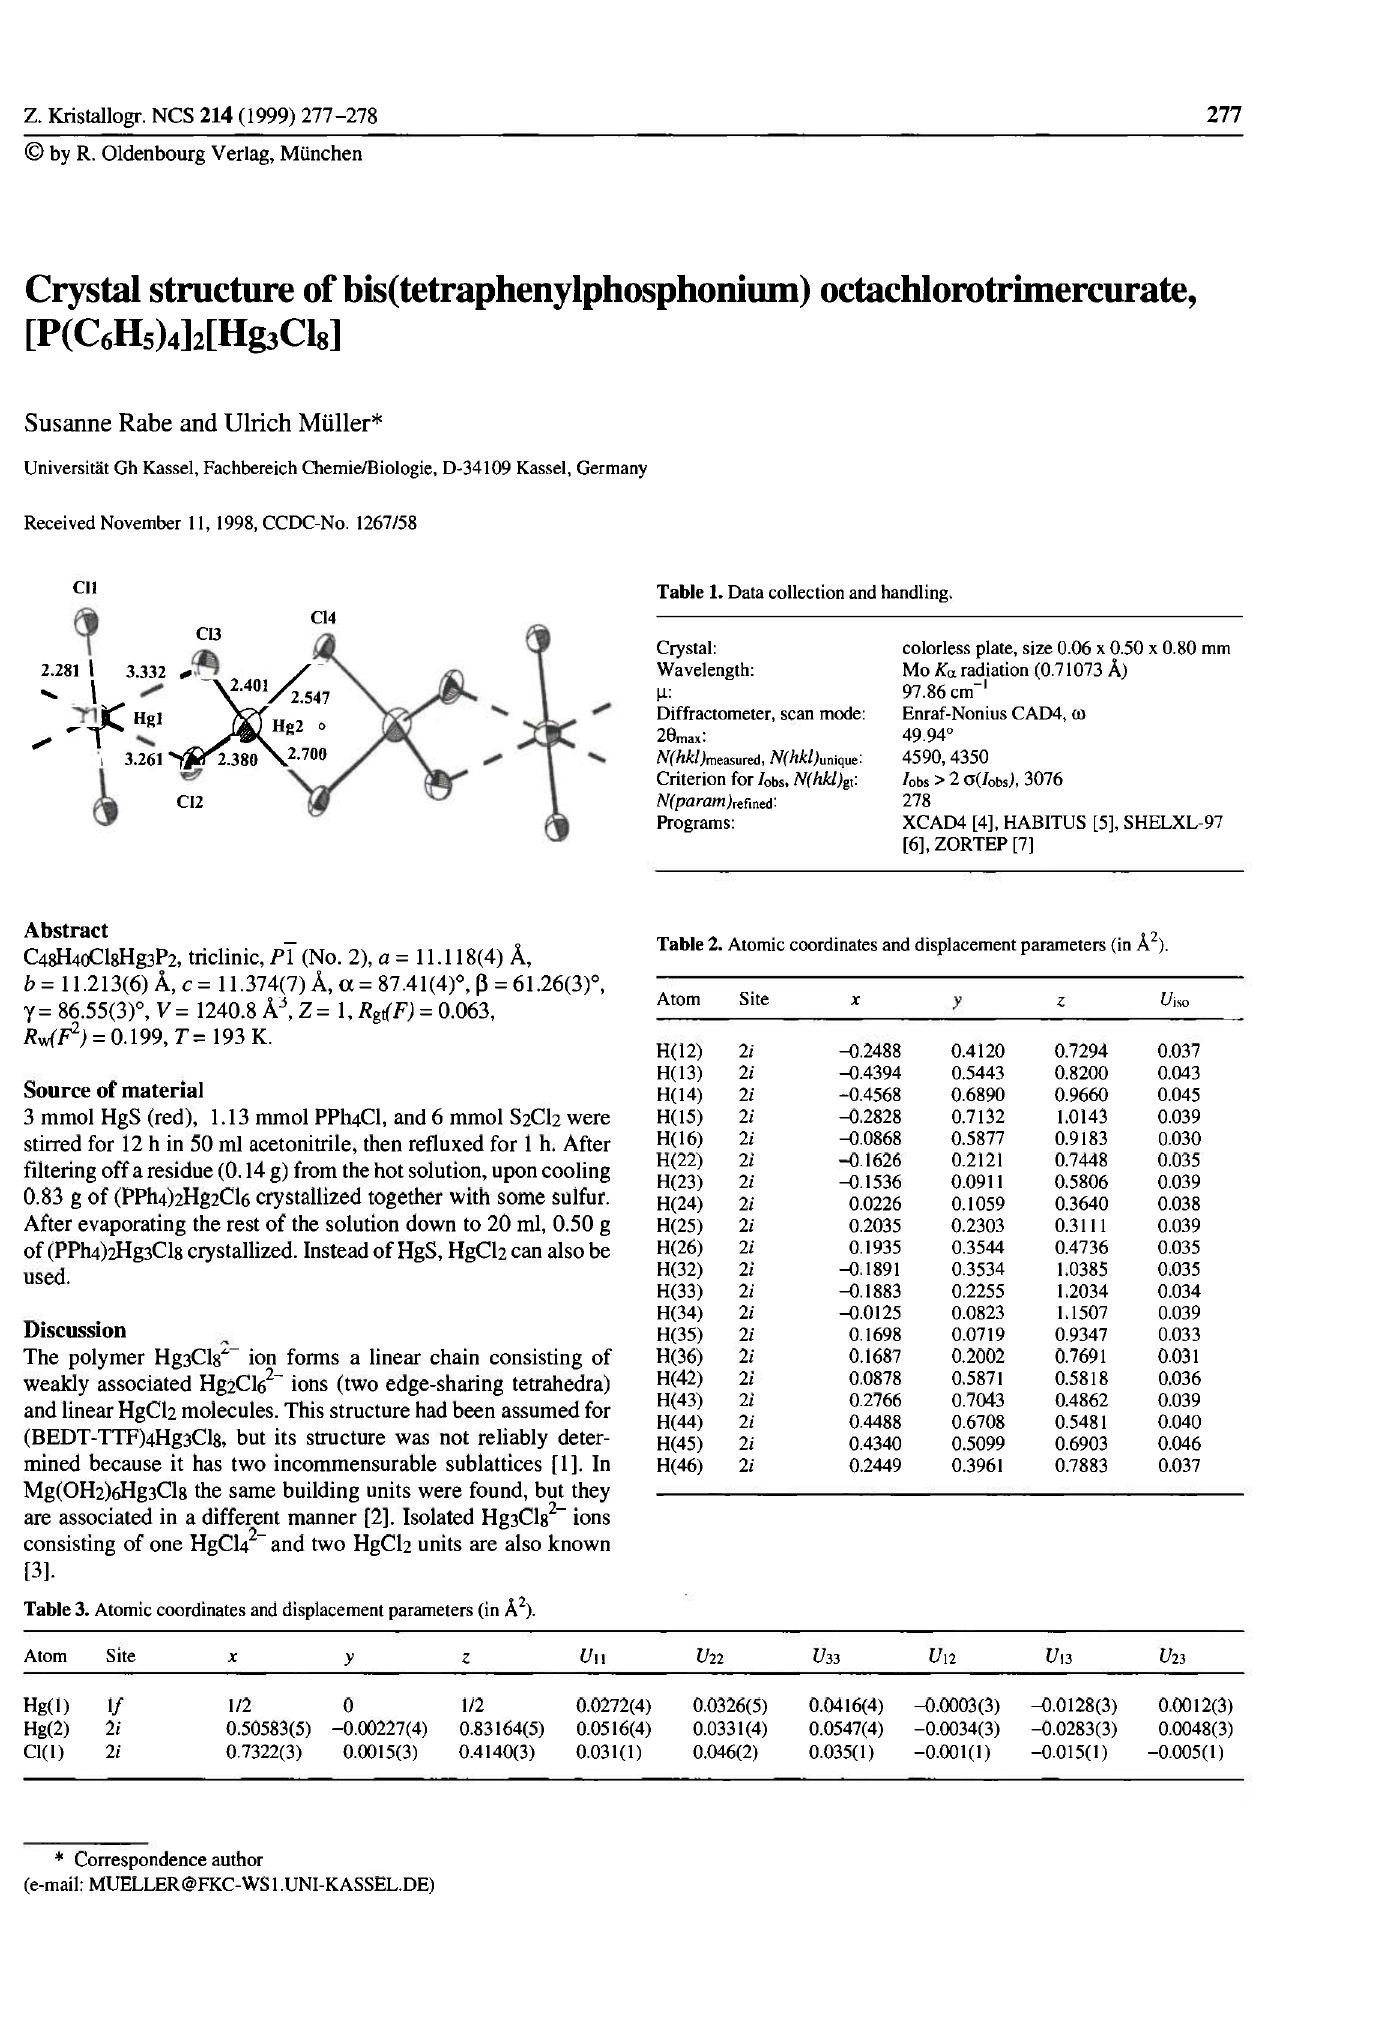
Table 3. Atomic coordinates and displacement parameters (in Ä 2